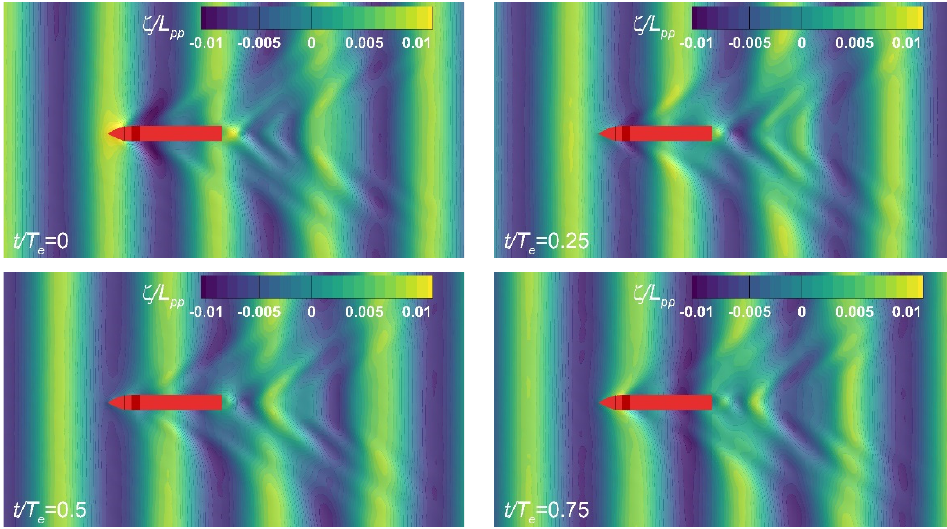
Figure 26. Free-surface elevations over a period of the following wave encounter.